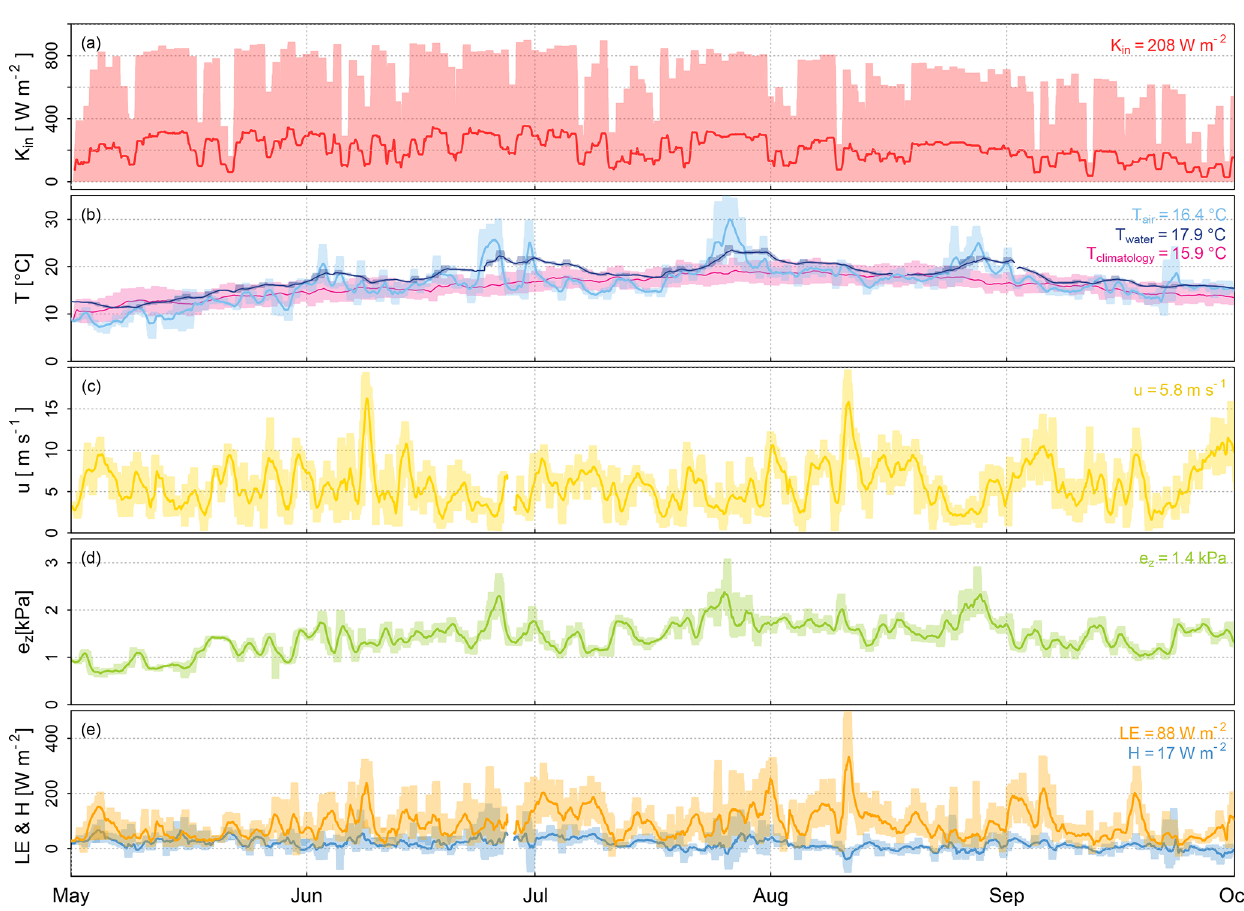
Figure 2. Meteorological conditions in Stavoren in 2019, showing running daily means of global radiation (a) , air temperature (current and climatology) and water temperature (b) , wind speed (c) , vapour pressure (d) , and turbulent fluxes (e) . The shaded area represents the range between the minimum and maximum observed values, and the numbers reported in the top right of each panel provide the average values of the respective variables during the presented